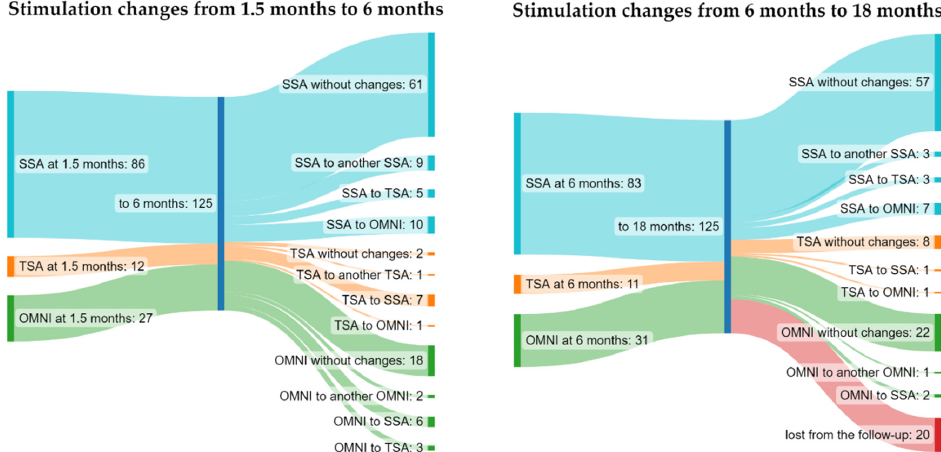
Figure 3. DBS stimulation changes during the 18-month follow-up. Numbers in each stimulation type represent the number of dDBS leads activated in each mode (SSA = single segment activation, TSA = two segment activation, OMNI = omnipolar stimulation, SSA to another SSA = SSA was changed within same electrode level, TSA to another TSA = TSA was changed within the same electrode level, OMNI to another OMNI = change in the active electrode level while stimulation was kept in omnipolar mode).